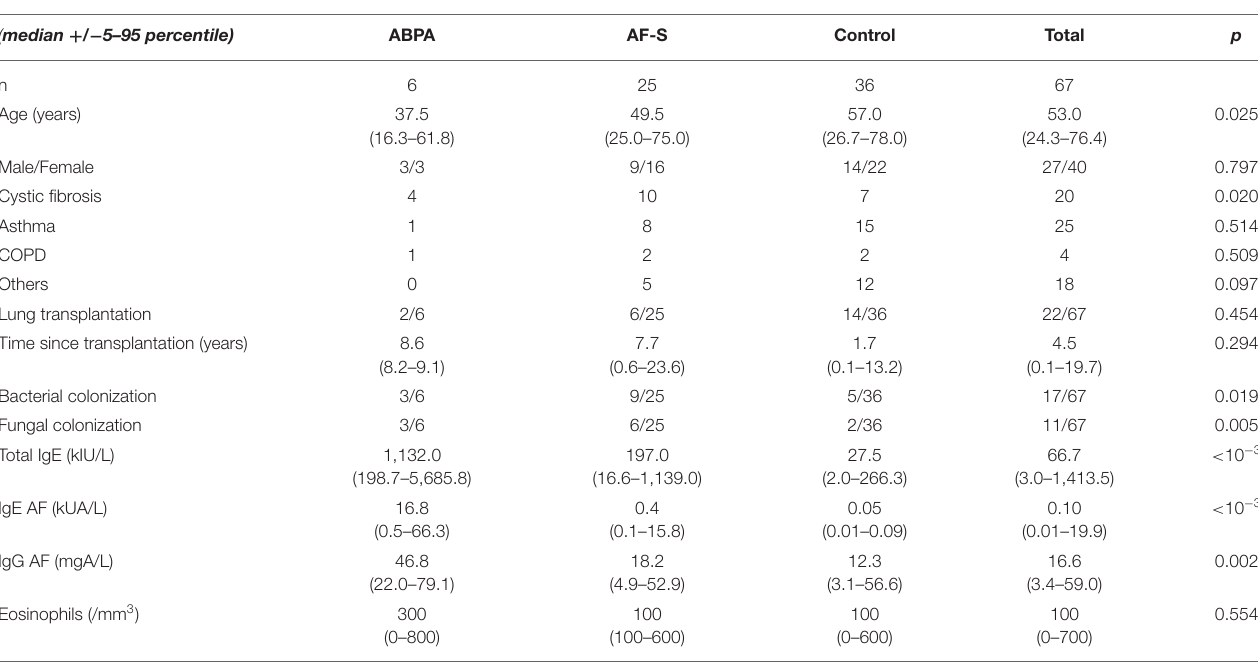
TABLE 1 | Demographic and laboratory data of the study